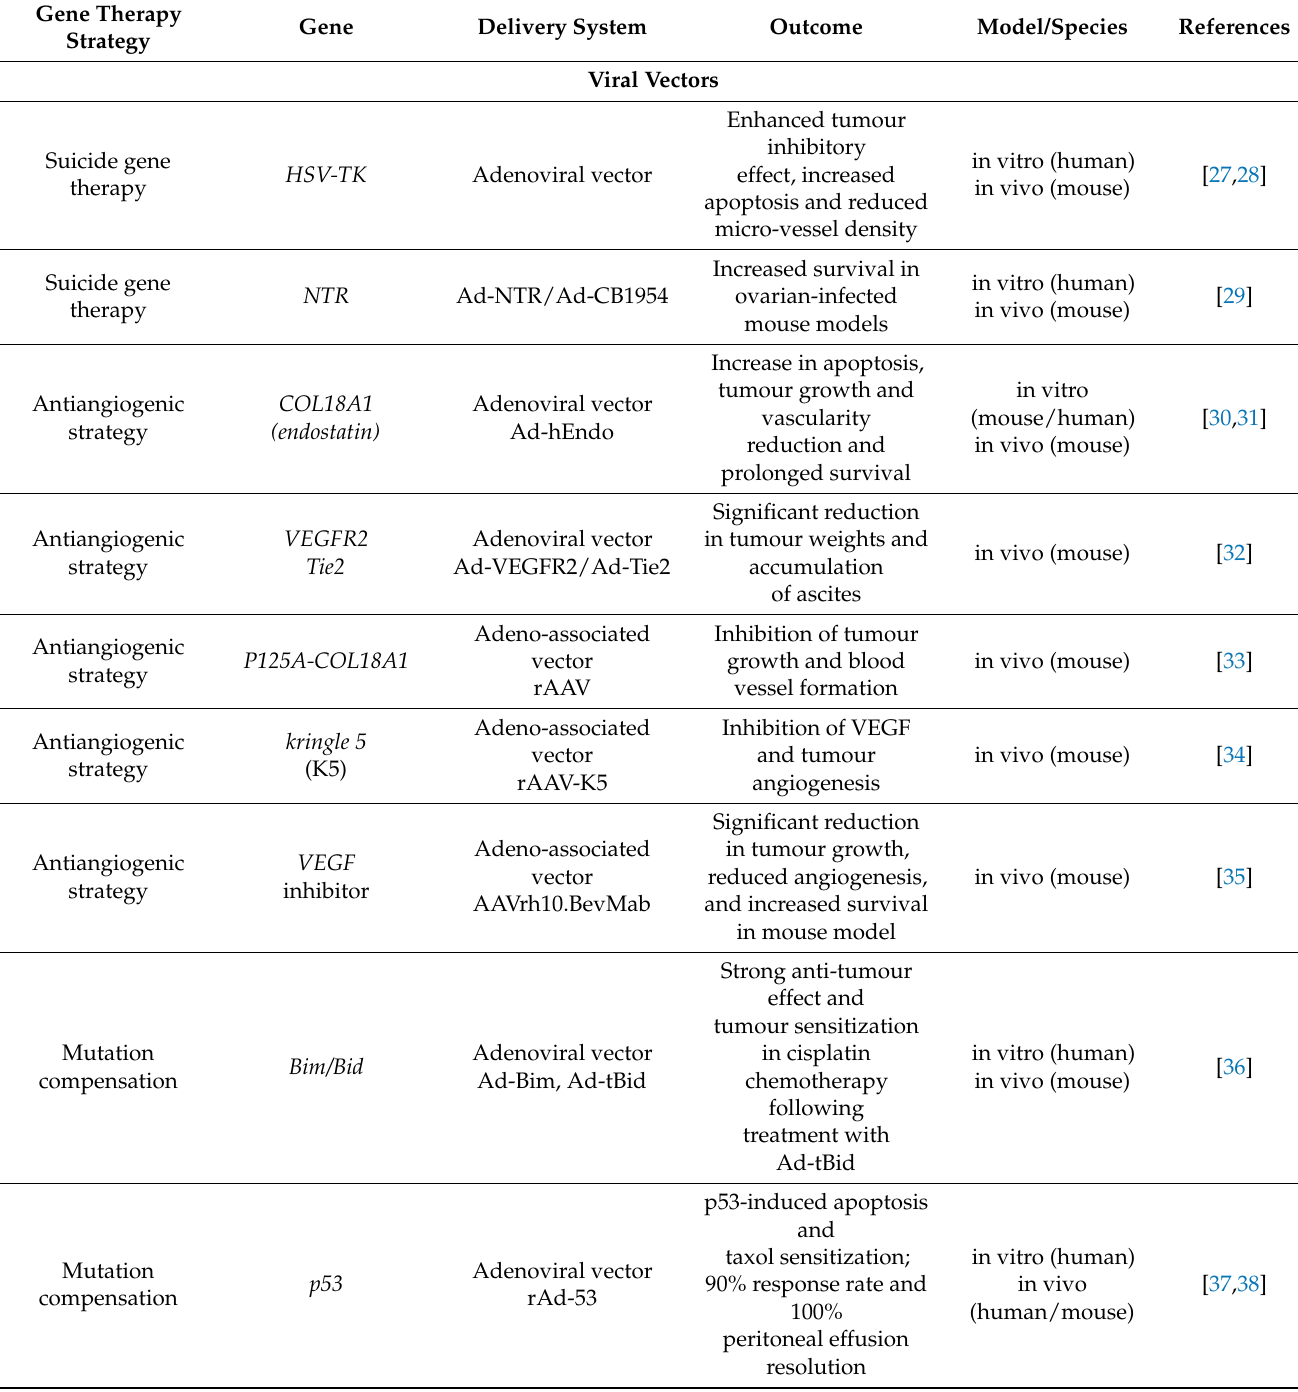
Table 1. Targeted gene therapy approaches for ovarian